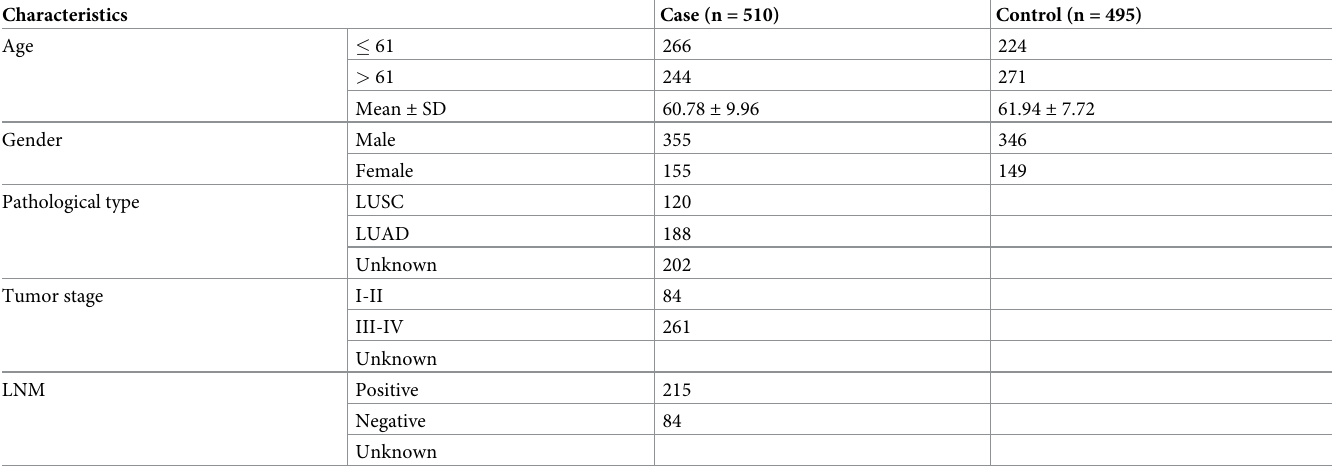
Table 1. The comparison of basic characteristics between cases and controls. Characteristics